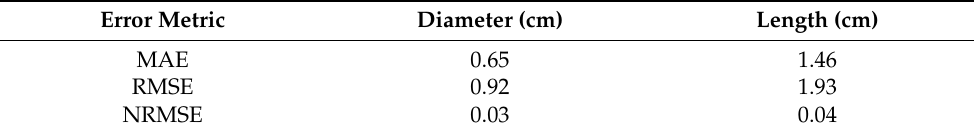
Table 2. Results on errors for the second experiment